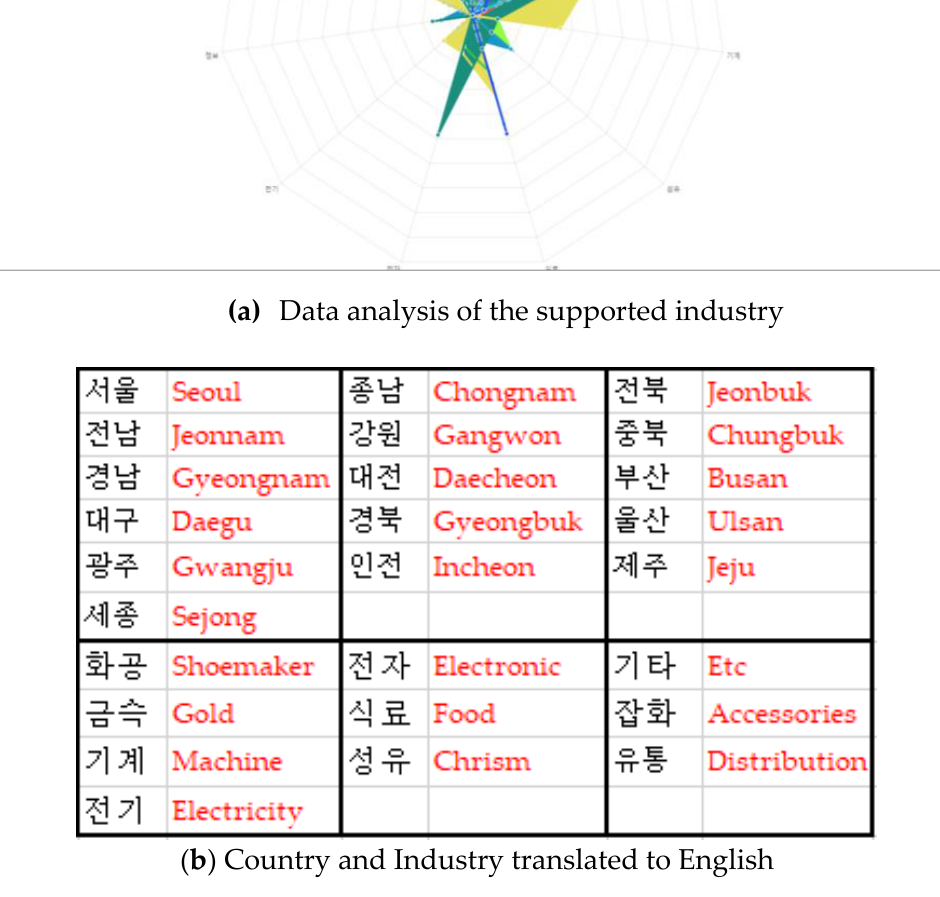
Figure 24. Data analysis of the supported industry.